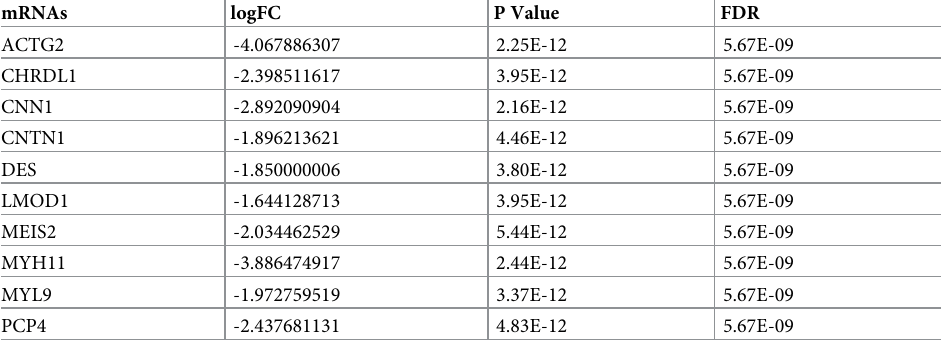
Table 3. Top 10 differential mRNAs for prostate